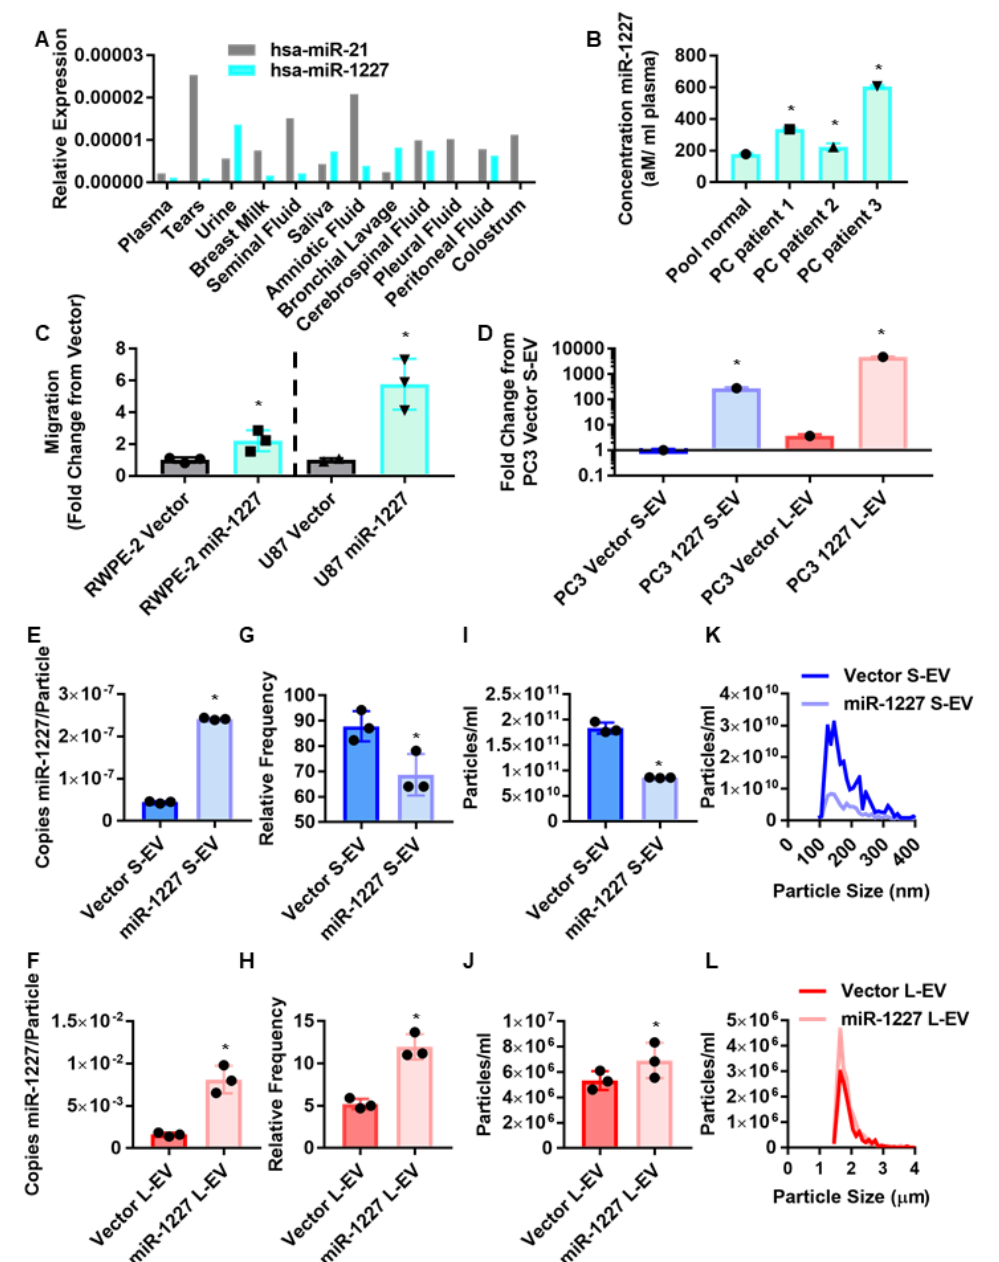
Figure 1. MiR-1227 induces shedding of L-EV and inhibits the shedding of S-EV in PC cells. ( A ) MiR-1227 (teal) and miR-21 (grey) expression in different biological fluids from Weber et al. 2010 [23]. ( B ) Taqman qPCR quantification of miR-1227 in EV isolated from pooled normal or PC patient plasma ( n = 1). ( C ) Transwell migration of RWPE-2 PC and U87 glioma cells stably expressing miR-1227 (teal) or empty vector control (grey) ( n = 3) normalized to corresponding vector control; ( D ) qPCR for miR-1227 from S-EV (blue) and L-EV (red) isolated from PC3 cells stably expressing miR-1227( n = 1). ( E , F ) Digital droplet qPCR quantification of miR-1227 per S-EV (E) and L-EV (F) ( n = 3). G,H). Atomic force microscopy quantifications of S-EV ( G ) and L-EV ( H ) shed from PC3 cells stably expressing miR-1227 ( n = 3). ( I – L ) Quantification of S-EV ( I ) and L-EV ( J ) shed from PC3 cells stably expressing miR-1227 by TRPS with size distribution plots in ( K ) and ( L ), respectively ( n = 3); * p < 0.05.